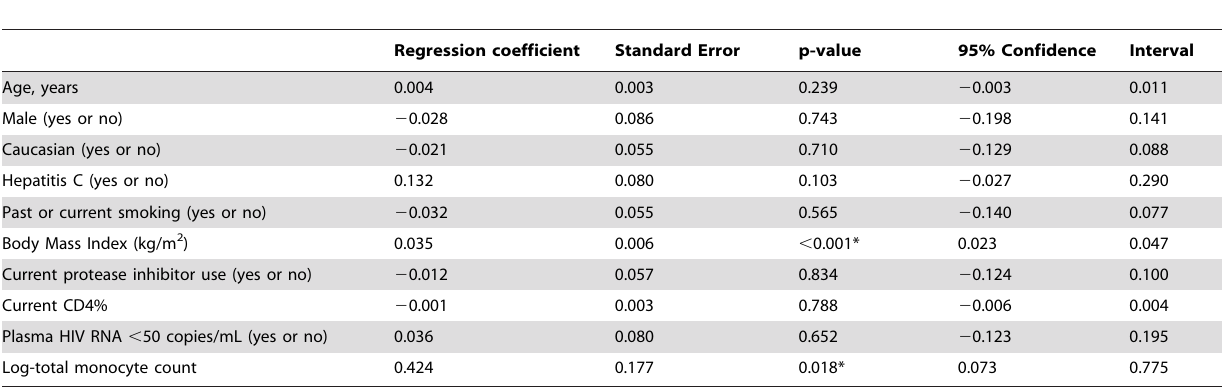
Table 2. Multivariate linear regression analysis of the relative contribution of total monocyte count to HOMA-IR adjusting for various HIV-associated and diabetes risk